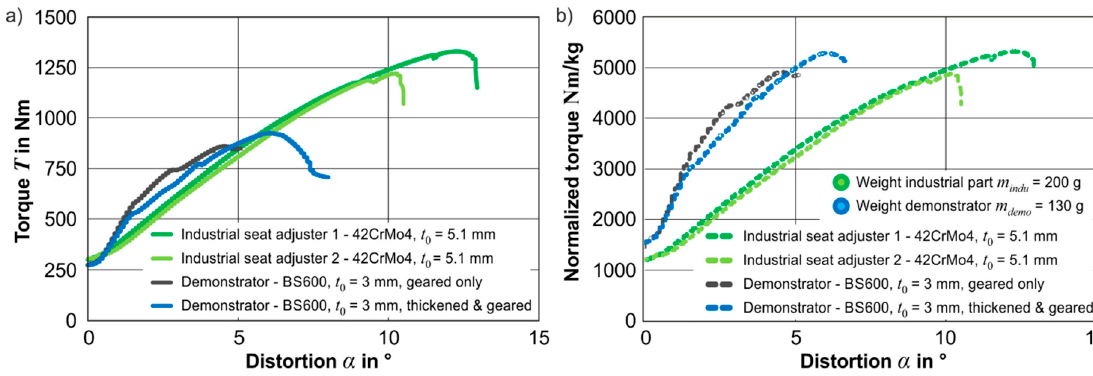
Figure 10. ( a ) Torque-distortion-curves of conventionally manufactured industrial seat adjusters and demonstrators manufactured by incremental sheet-bulk metal forming (iSBMF). Both with modulus m test = 2.44 mm, ( b ) torque-distortion-curves normalized by the weight of the component.